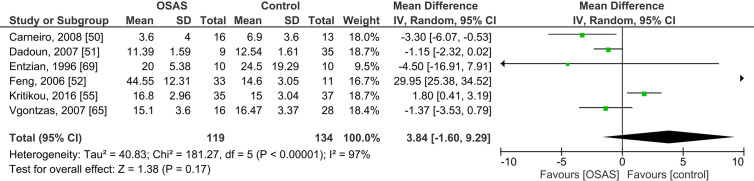
Forest plot of random-effects analysis of plasma cortisol levels in adult obstructive sleep apnea syndrome (OSAS) versus the control group. The diamond shape indicates the pooled mean difference (MD). Each black box represents a point estimate of each study and also gives a representation of the study size (the bigger the box, the more participants in the study). A horizontal line representing the 95% confidence intervals (CIs) of the study result, with each end of the line representing the boundaries of CI. SD, Standard deviation.